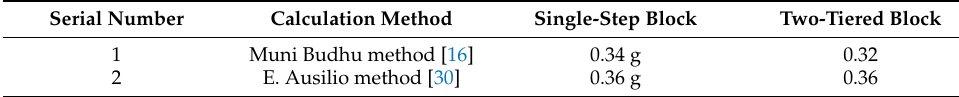
Table 4. Calculation value of the yield